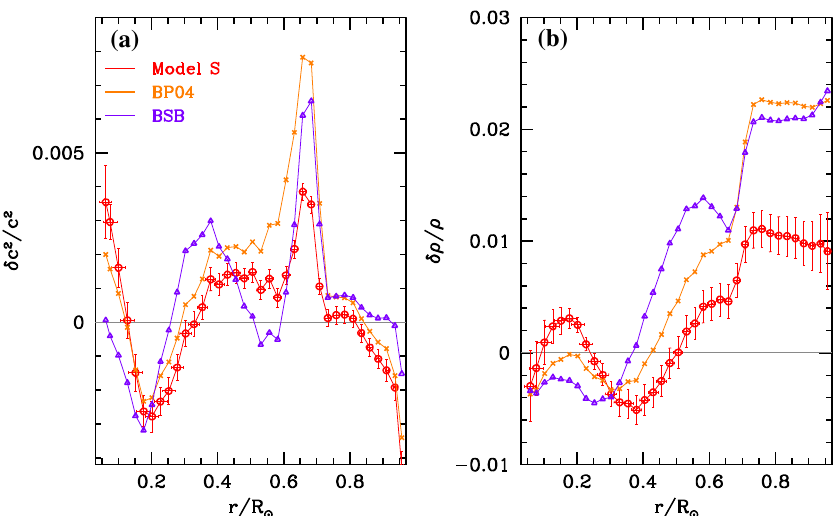
Fig. 16 The relative difference in the squared sound speed and density between the Sun and three solar models used earlier in Fig. 7. The difference are in the sense (Sun–Model). The results are from Basu et al. (2009)obtainedusingtheirBiSON-13dataset.Inthefigurethe verticalerror-bars show3 σ uncertaintiesin theresultscausedbyerrorsintheinputfrequencies.The horizontalerror-bars areameasureoftheresolution of the inversions. They showthe distance between the first and third quartile pointsof the resolution kernels. Error-bars are only shown for one model for the sake of clarity, they are the same for all